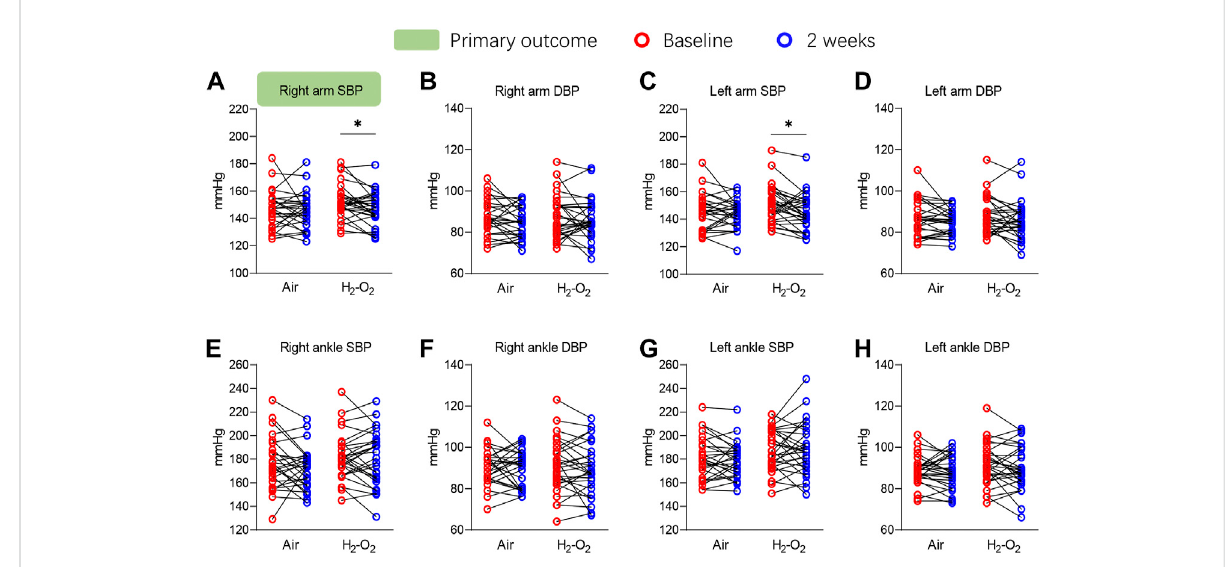
FIGURE 2 Four-limb blood pressure at baseline and after 2 weeks of intervention. SBP, systolic blood pressure; DBP, diastolic blood pressure. Data are represented as the mean ± SD; * p < 0.05 by paired t